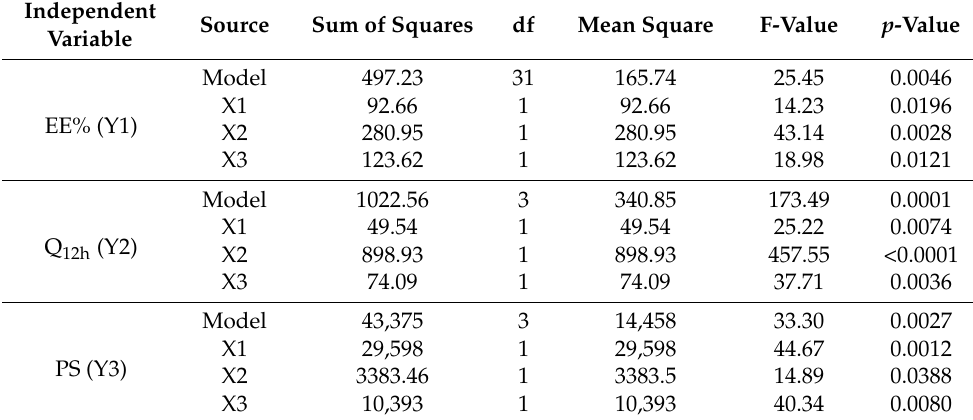
Table 3. ANOVA for the 2 3 factorial design of EGCG-loaded